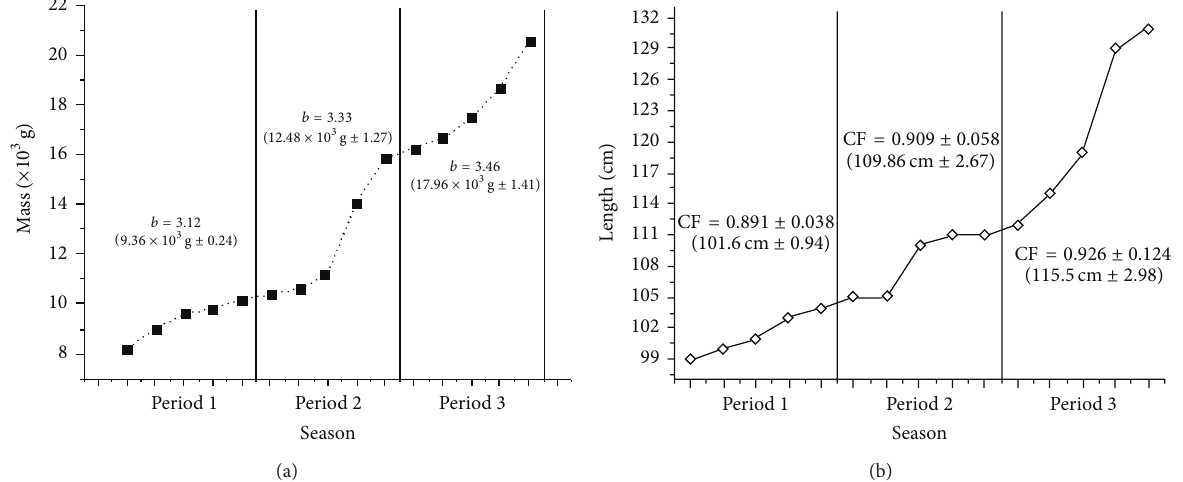
Figure 4: Variations in mass and estimated values for the regression constant “ 𝑏 ”, rate of growth in mass (a); variations in length and condition factor (CF), (b) to A. gigas in Period 1 (9.99 mm 3 , 26.14 ∘ C), Period 2 (2.74 mm 3 , 25.46 ∘ C), and Period 3 (5.8 mm 3 , 26.94 ∘